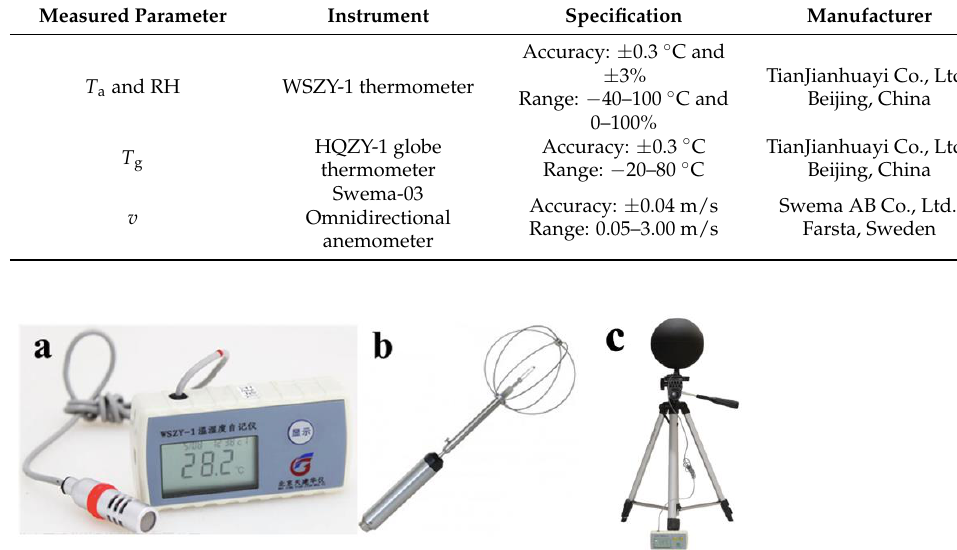
Figure 4. ( a ) WSZY-1 thermometer, ( b ) Swema-03 Omnidirectional anemometer, and ( c ) HQZY-1 globe thermometer. Table 4. Information on the instruments.